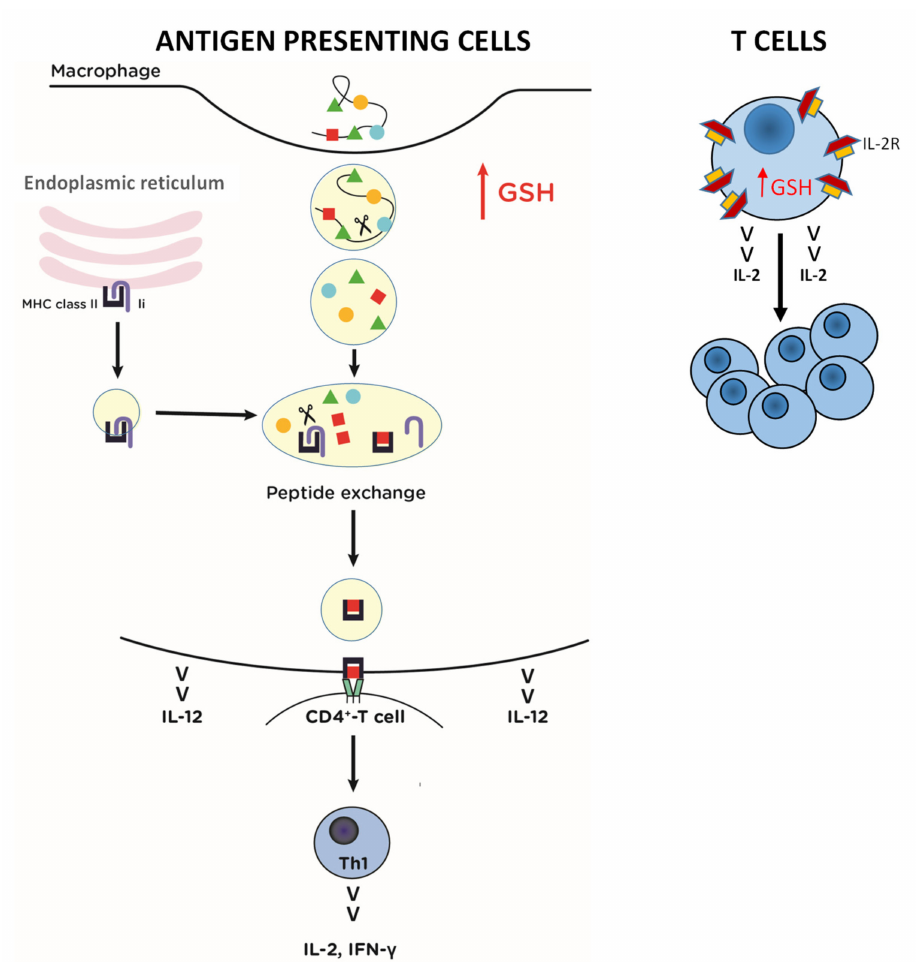
Figure 4. Possible effects of increased GSH in antigen presenting cells, i.e., macrophages (left) and T cells (right). In macrophages high levels of GSH favor: (1) antigen processing and presentation; (2) IL-12 production that induces differentiation of CD4 + -Th0 cells in Th1. In T cells high levels of GSH favor: (1) IL-2 production; (2) proliferation; (3) IL-2R expression on T cell membranes. IL-12 interleukin 12; IL-2 interleukin 2; IFN- γ : interferon γ ; IL-2R: IL-2 receptor; MHC II: major histocompatibility complex class